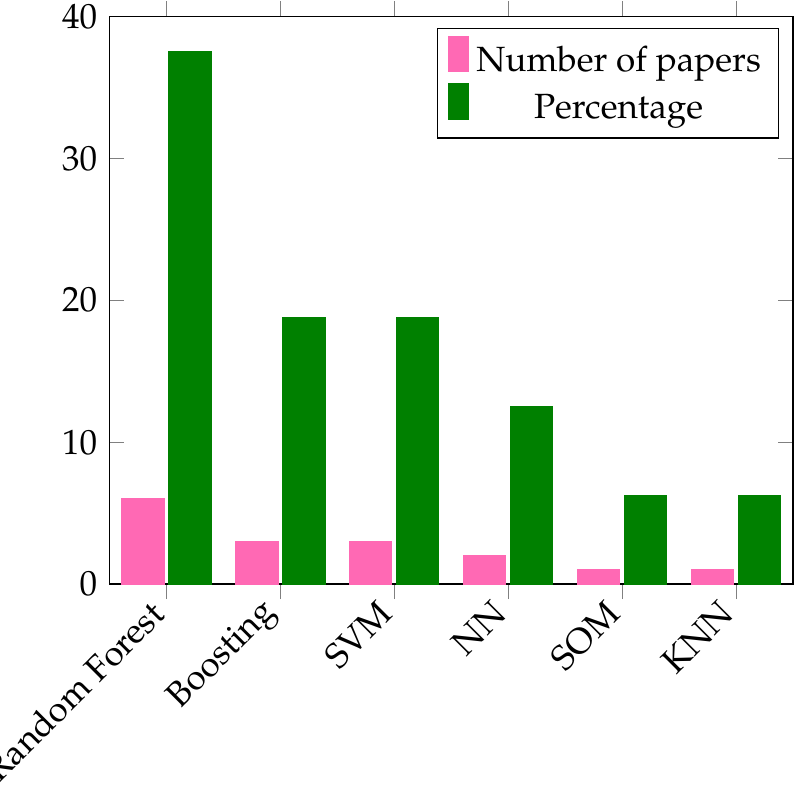
Figure 9. Distribution of reviewed classical machine learning techniques